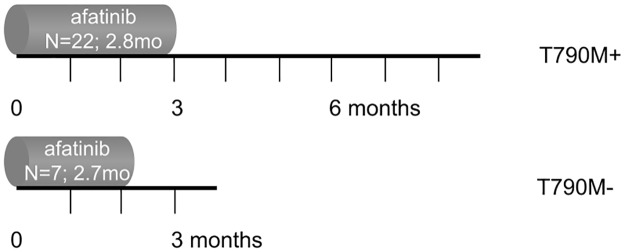
Median PFS in OS axis for sequential treatments in T790M positive and negative advanced NSCLC patients.Survival outcome of afatinib treatment is shown after first generation EGFR-TKI treatment. The X-axis represents the overall survival. The bars indicate the progression free survival for afatinib.